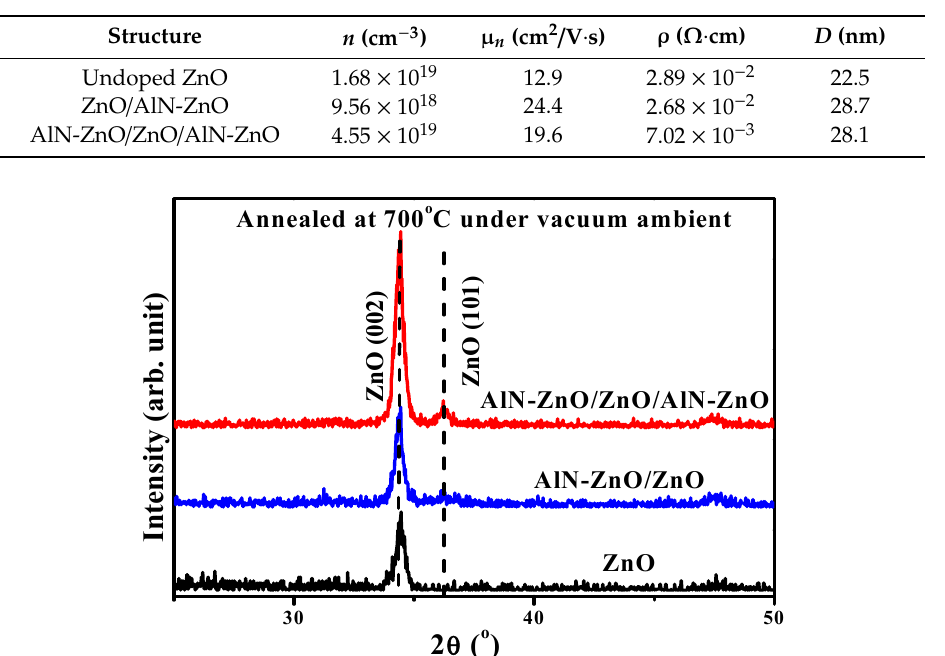
Table 2. Carrier concentration, mobility, and resistivity of the undoped ZnO film deposited onto the substrate with and without an AlN-ZnO (20%) buffer layer as well as the ZnO film sandwiched in the AlN-ZnO cosputtered films, after annealing at 700 °C under vacuum ambient for 30 min (the crystal size, D , evaluated from the full width at half maximum (FWHM) of the ZnO (002) phase in the XRD patterns also is given). Structure